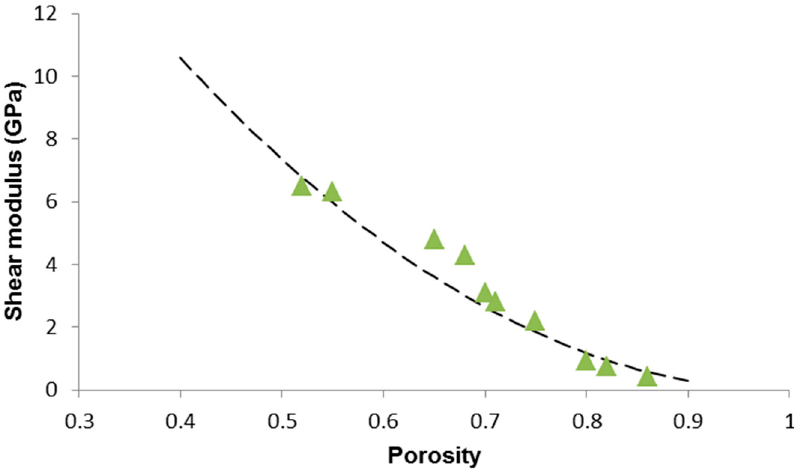
Figure 6. Porosity dependence of shear modulus in 45S5 glass-derived foams with data interpolation by applying the Gibson–Ashby power-law model (Equation (10)).